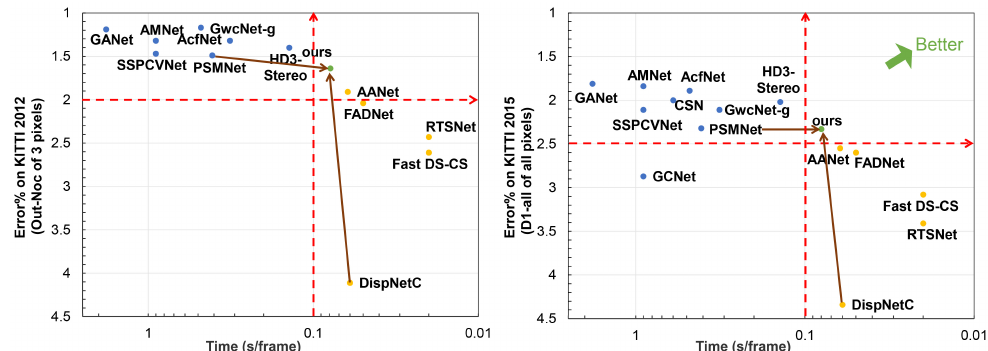
Figure 1. The visualization of speed and accuracy for recent stereo methods. We select the main evaluation metric for comparison from the KITTI official website. The smaller the x coordinate value, the faster the speed. The smaller the y coordinate value, the higher the accuracy. Blue dots represent accurate 3D networks, while yellow dots represent fast 2D networks. The green dot is our proposed method, a high-precision network with fast